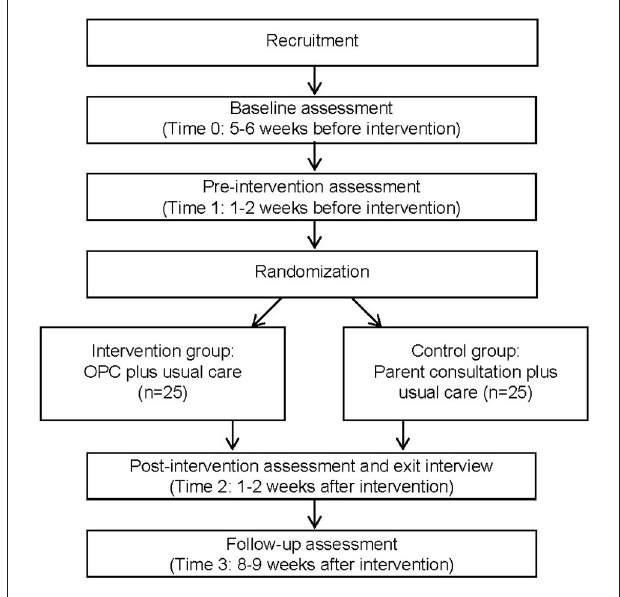
FIGURE 1 | Flowchart of data collection. OPC, Occupational Performance